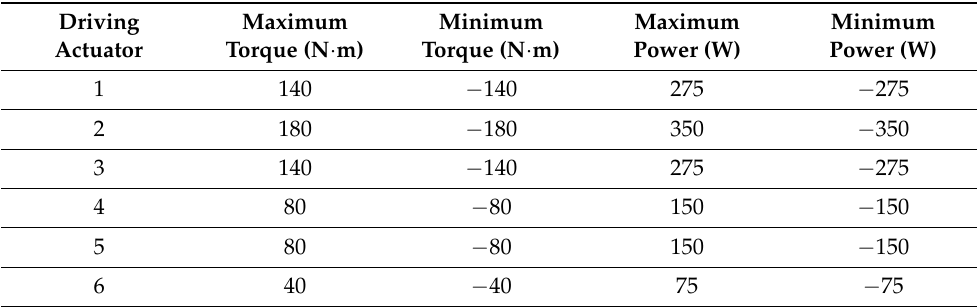
Table 1. Power and torque for each driving actuator (PUMA 560 industrial